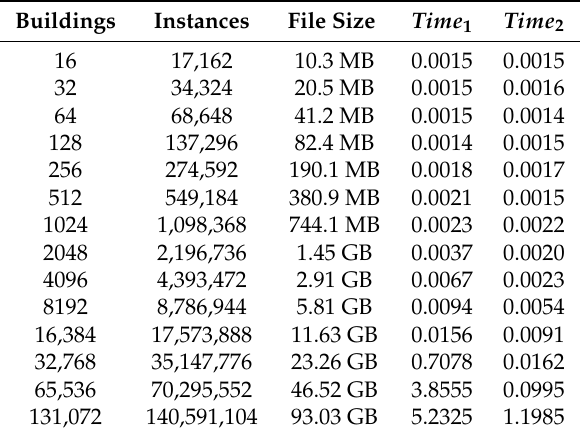
Table 8. Computing times (in hours) using synthetic big data for two different hardware